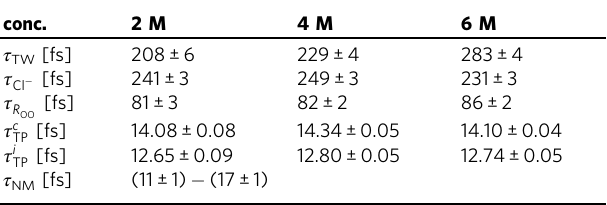
Thestandarderrorsof the transfer-waiting time τ TW and thetransfer-pathtimes τ i TP and τ c TP are estimated from the variances of the fi tted distributions. The errors of the normal-mode times τ NM , the oscillation time of the two fl anking water molecules τ R chloride ions τ Cl (cid:4) are estimated from the resolution of the underlying